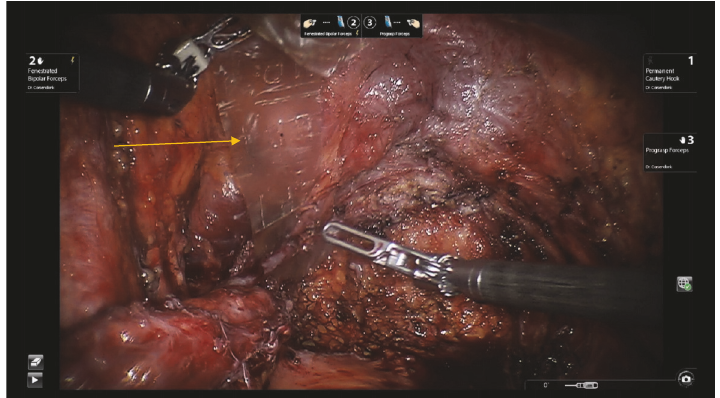
Figure 2: AmnioFix membrane wrapped around the site of left ureteral injury. AmnioFix membrane identified by yellow arrow.